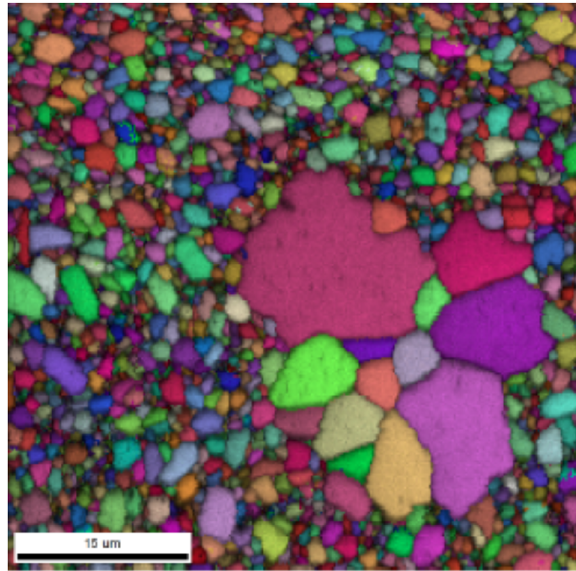
Fig. 1 A prototypical microstructure, as obtained from electron backscatter diffraction (EBSD), highlighting abnormal grains in a background of ‘‘ normal grains ” for an alumina sample. Reprinted with permission from Elsevier, Ltd